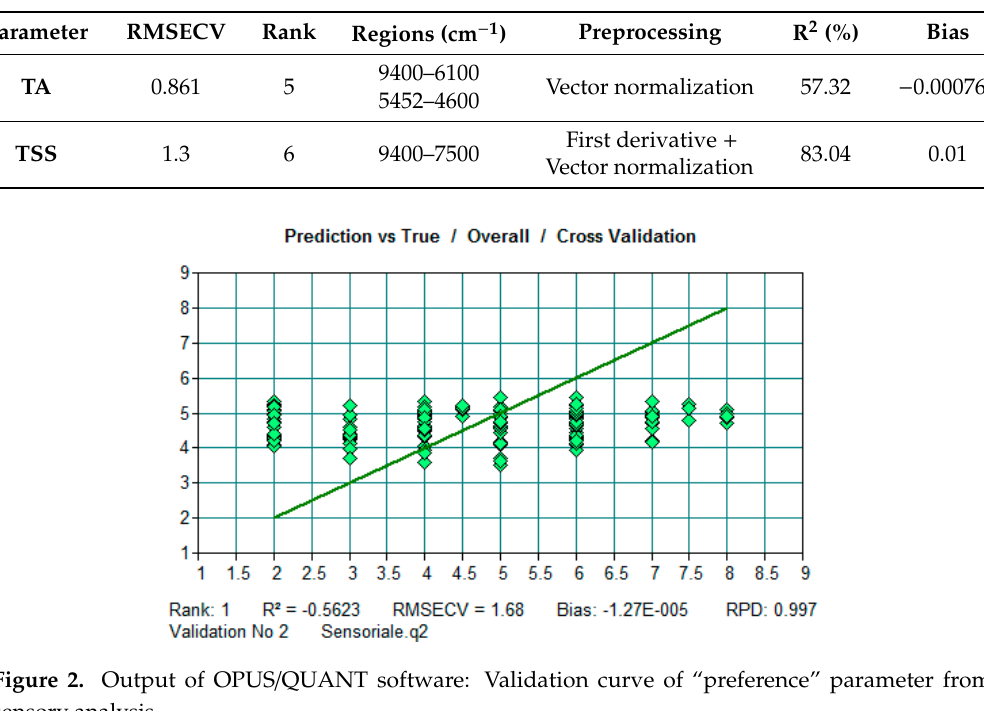
Table 1. Quality of the models obtained with the PLS algorithm. TSS: total soluble solid content; TA: titratable acidity; RMSECV: root mean square error of cross validation.